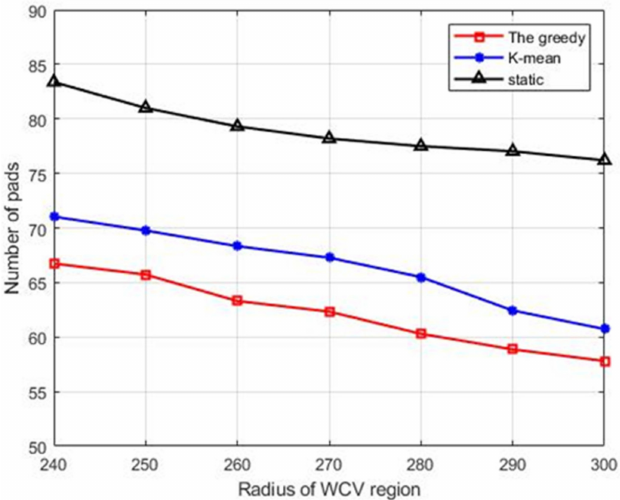
Figure 10. Comparison of the number of pads when the radius of the WCV region